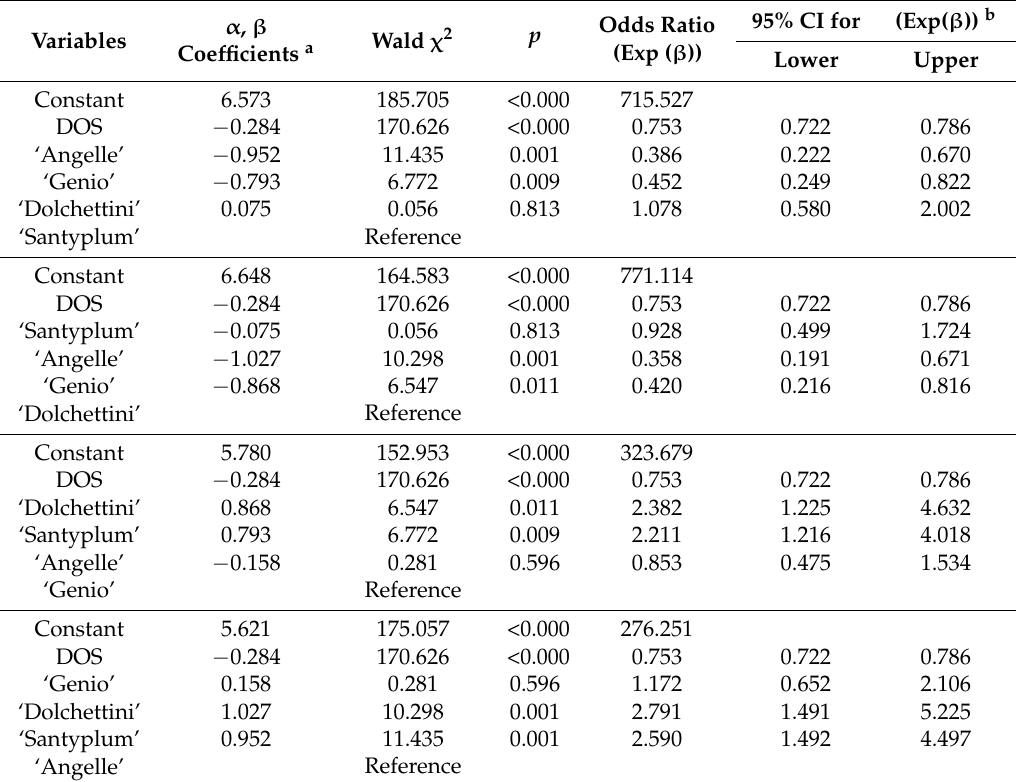
influencing factors on the marketability 3.2. Effects of the Cultivar and Days of Storage as Influencing Factors on the Marketability Probability